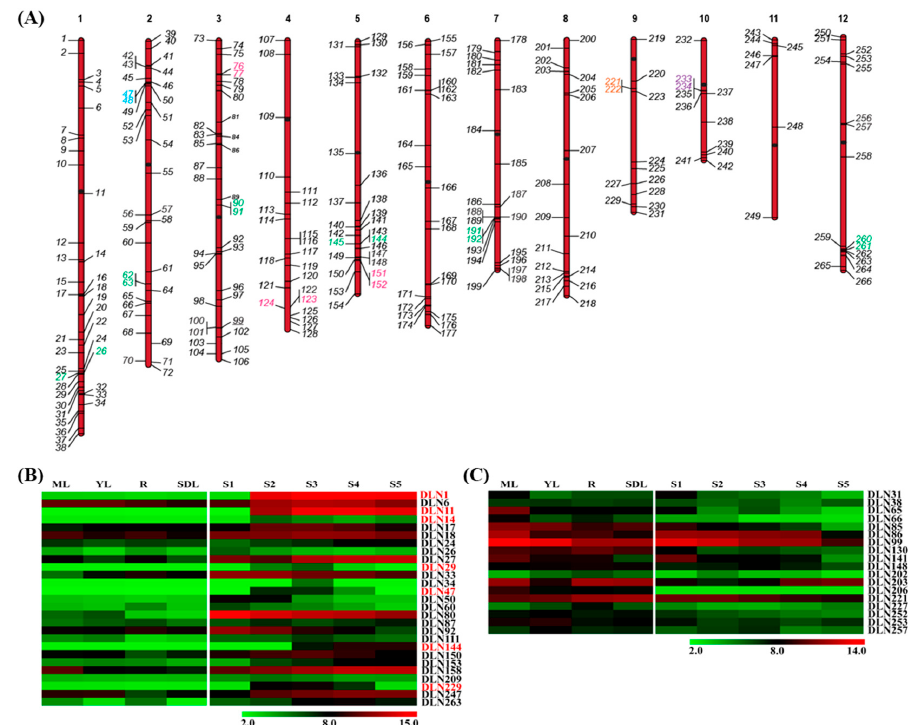
Figure 1. Distribution and expression of DLN repressors encoding genes. ( A ) Chromosomal localization of genes coding for 266 DLN repressors on 12 chromosomes of rice, genes in opposite orientation have been marked on either side and chromosome numbers are mentioned on top. The numbers represent the motif names in the encoded protein. Tandemly duplicated genes have been marked in green, blue, orange, pink, and purple from C2H2, PHD, bZIP, AP2, and btb_poz families, respectively. Heat map has been shown for genes at least two folds significantly ( B ) up- and ( C ) downregulated during rice seed development stages (S1–S5), with respect to vegetative controls (ML—mature leaf, YL—leaf, R—root, SDL—7-day-old seedling). The seed-specific genes have been marked in red in ( B ) and the color legends are shown at the bottom of the heat map.